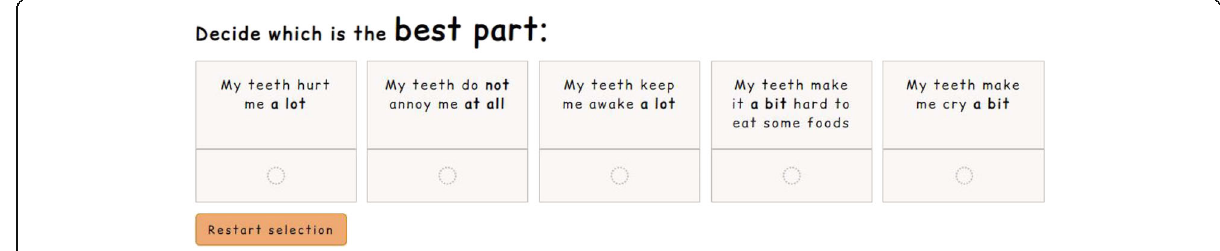
Fig. 2 Example of a best-worst scaling task from the